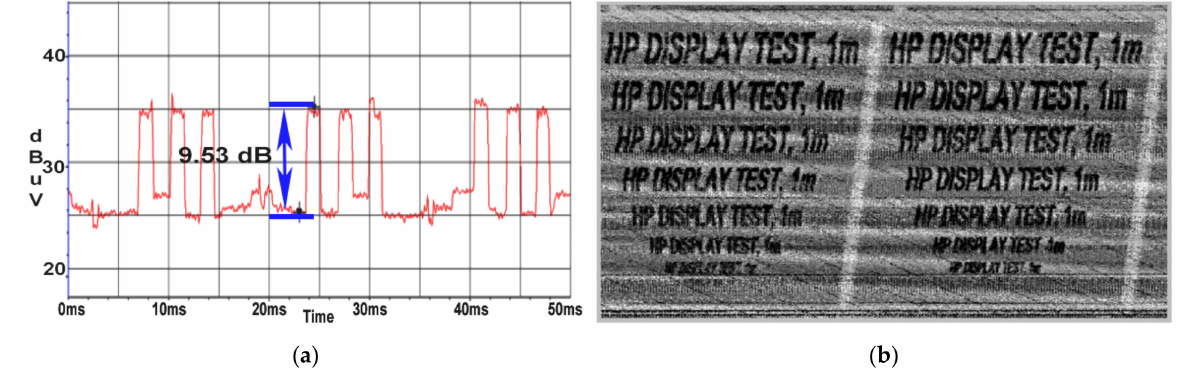
Figure 16. HP display: ( a ) SNR measured at a distance of 1 m; ( b ) image recovered at a distance of 1 m.